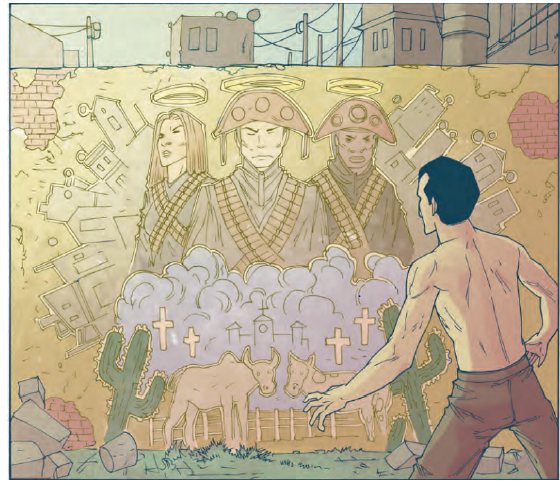
Figure 5. Wellington and Walter Geovani. Cangaço Overdrive (p. 36) Courtesy of the artists.